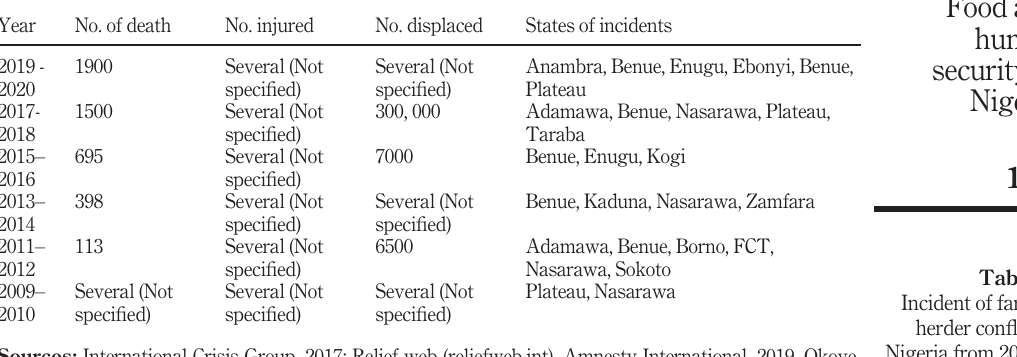
Table 3. Incident of